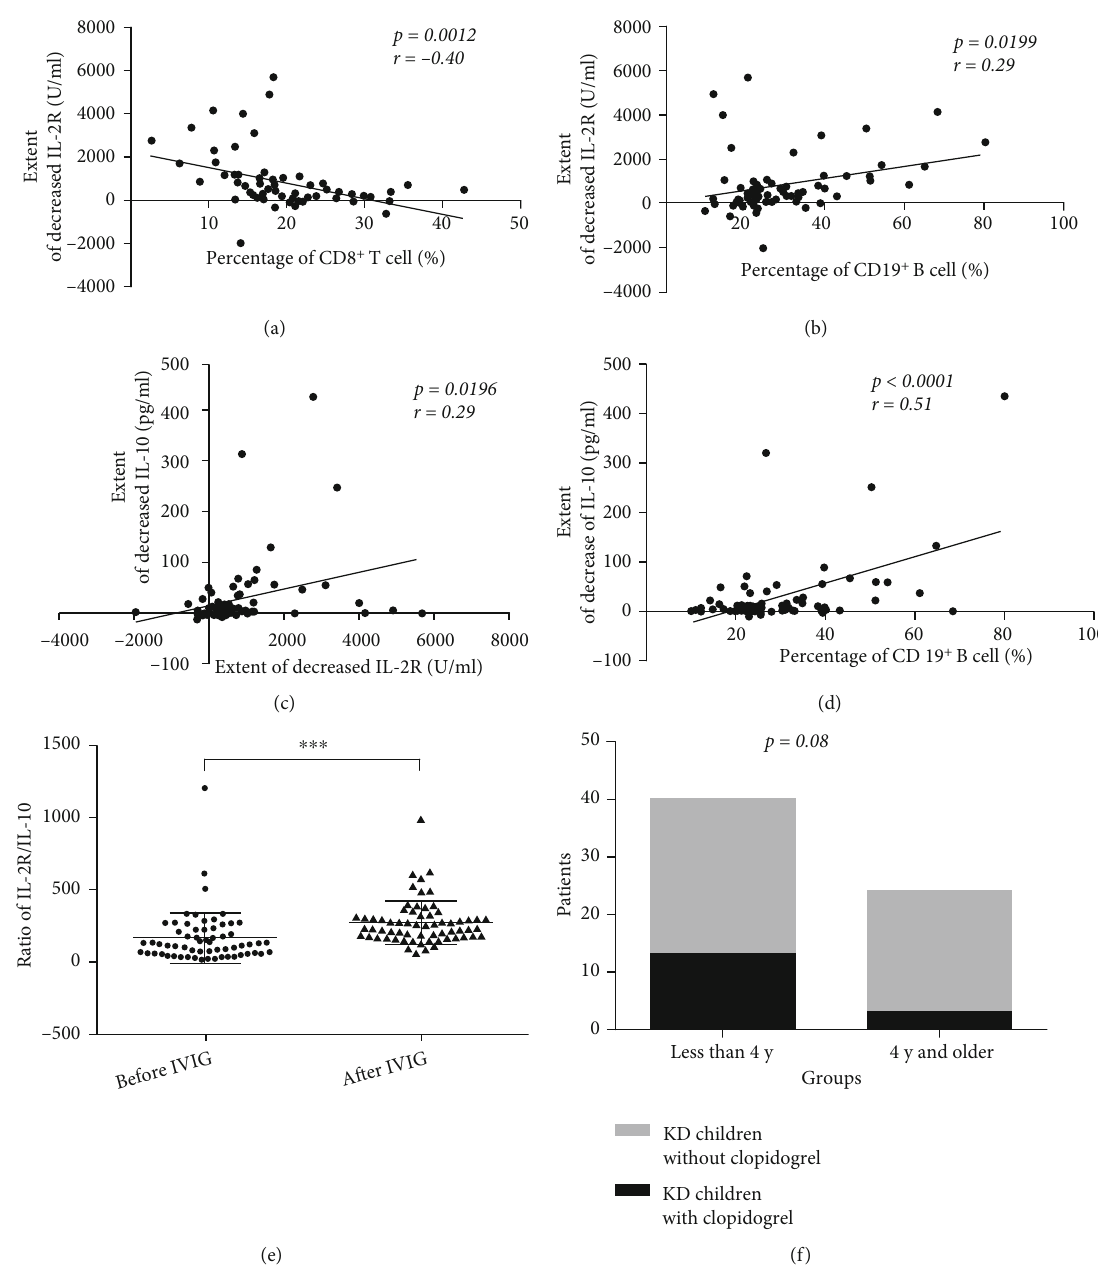
Figure 3: Association between altered levels of IL-2R and IL-10 and the percentages of CD8 + T and CD19 + B cells in all children with KD during KD and the distribution of KD children treated with clopidogrel between children with KD who were < 4 years and children with KD who were ≥ 4 years. (a) Decreased levels of IL-2R were negatively correlated with the percentage of CD8 + T cells in children with KD. (b) Decreased levels of IL-2R were positively correlated with the percentage of CD19 + B cells in children with KD. (c) The extent of the decrease of IL-2R was positively correlated with that of IL-10. (d) The extent of the decrease of IL-10 was positively correlated with the percentage of CD19 + B cells in children with KD. (e) The mean value of the ratio of IL-2R/IL-10 before IVIG treatment was lower than that after IVIG ( ∗∗∗ P < 0 : 001 ), which were, respectively, 162 : 6 ± 22 : 16 and 271 ± 19 : 29 . (f) There was no di ff erence in the number of children with KD treated with clopidogrel between patients who were < 4 years old and patients who were ≥ 4 years